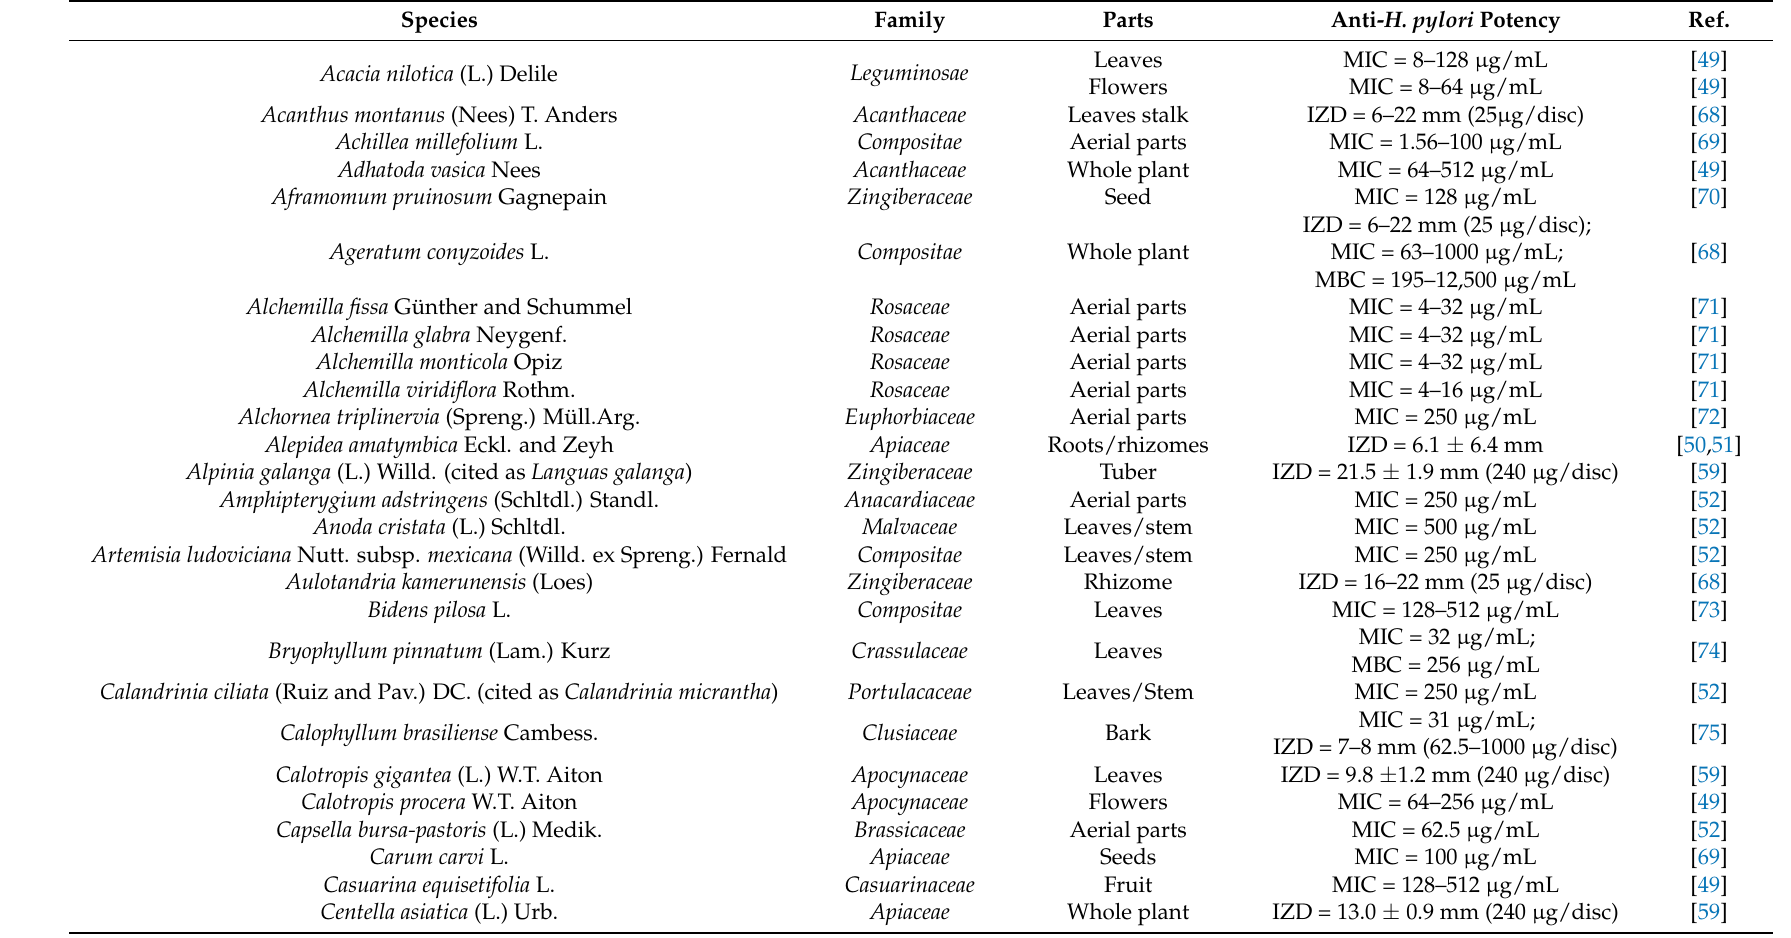
Table 4. Plant methanolic extracts with anti- H. pylori